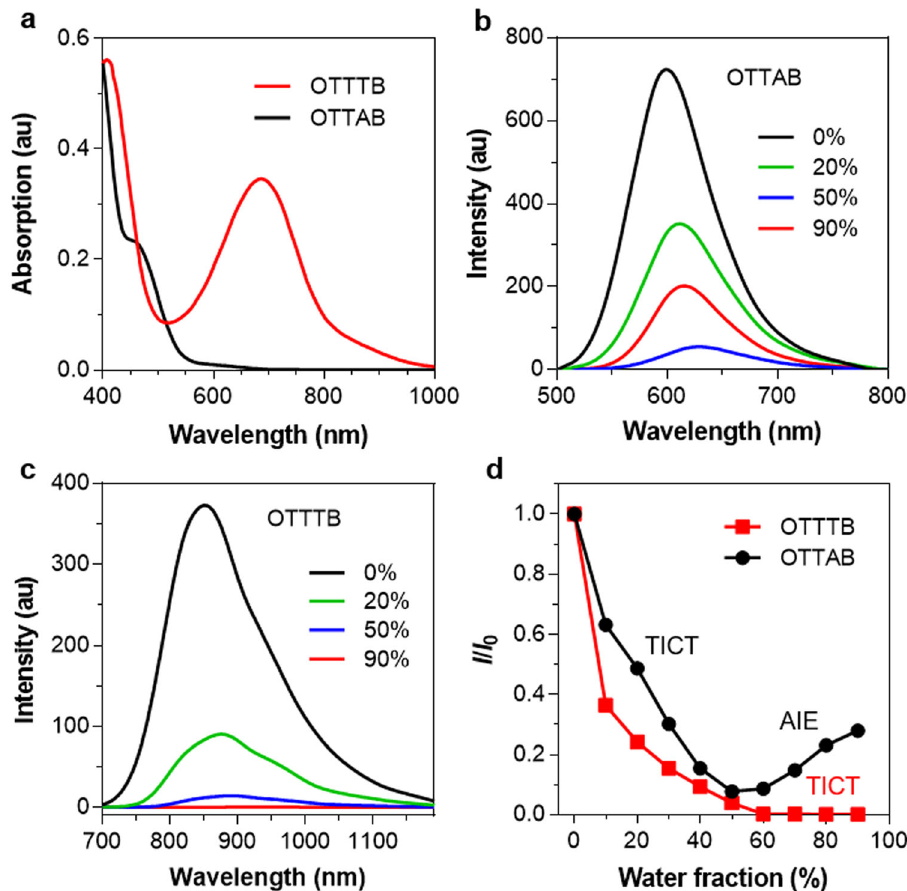
Fig. 2 Photophysical properties before and after NO treatment. a Absorption spectra of OTTAB and OTTTB in THF (10 − 5 M). PL spectra of b OTTAB and c OTTTB (10 − 5 M) in THF/water mixture with various water fractions ( f w ) as indicated (The excitation wavelengths of OTTAB and OTTTB are 460 and 680 nm, respectively.) d Plot of the PL peak intensity of OTTAB and OTTTB (10 − 5 M) versus water fractions in THF/water mixture. I 0 and I are the PL peak intensities in pure THF ( f w = 0) and THF/water mixtures with speci fi c f w s, respectively.